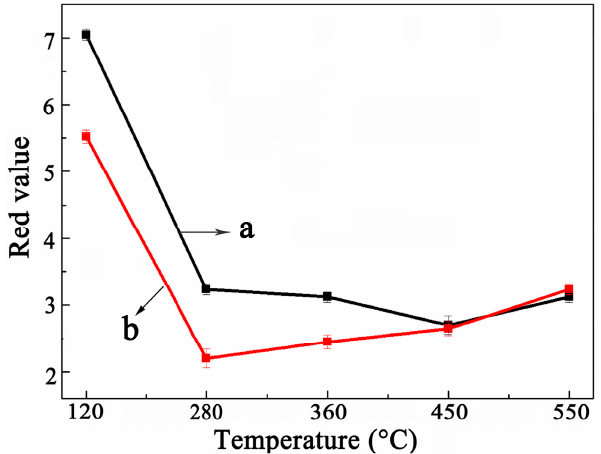
Figure 3. Change of red values of crude palm oil after being decolored by the APT ( a ) and C/APT ( b ) calcined at different temperatures (SD, n = 6).